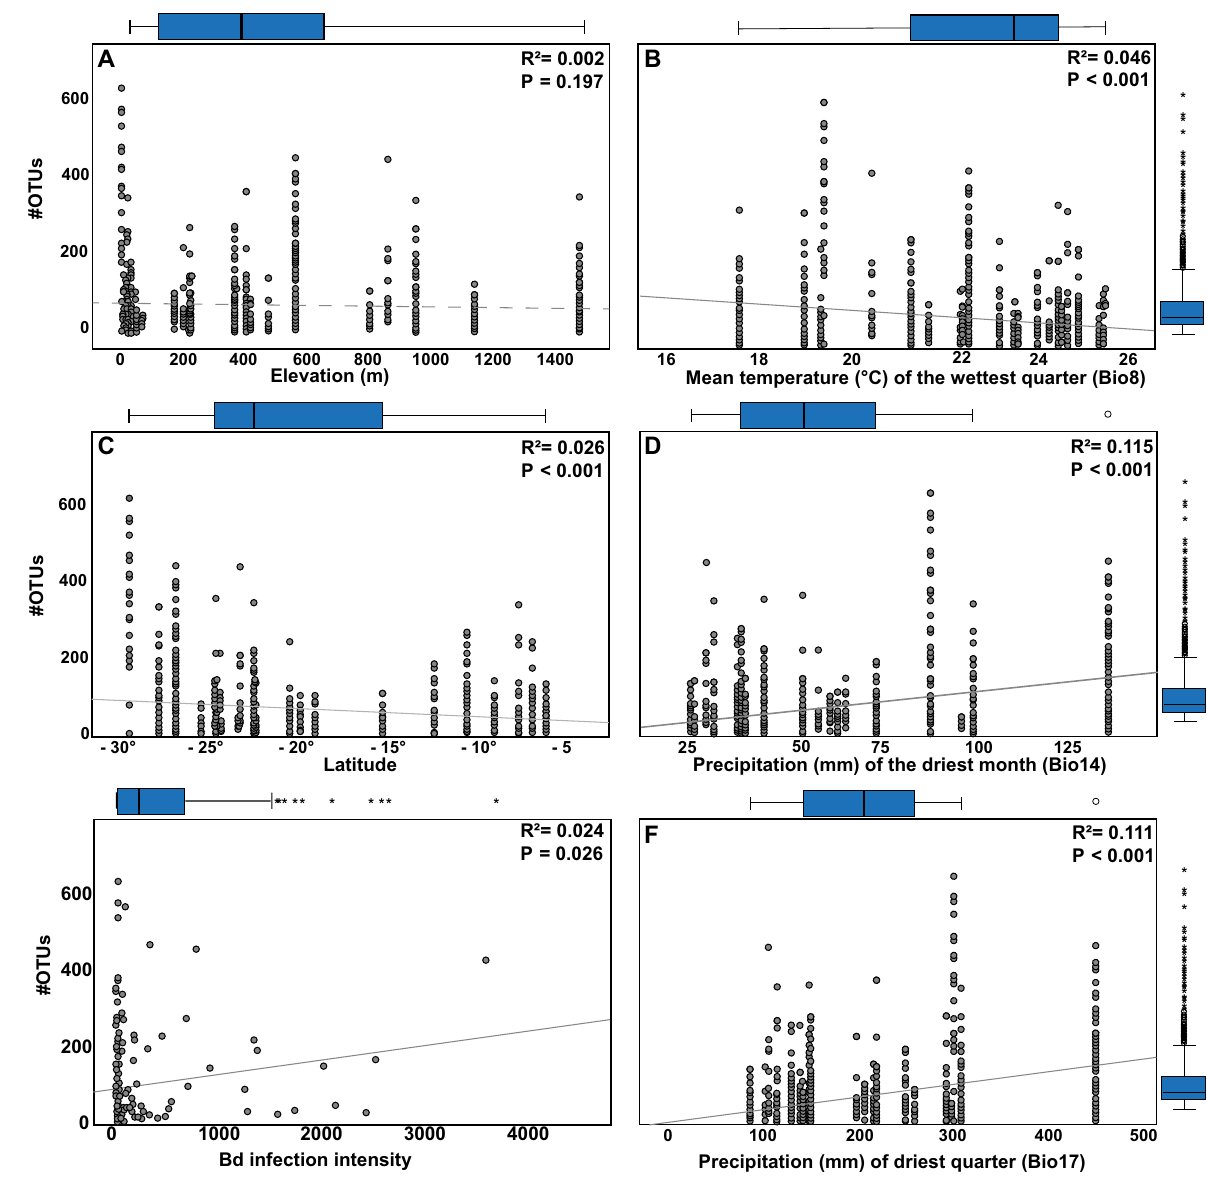
Figure 2. Richness (i.e. #OTUs) of treefrog (N = 819) skin bacterial communities is negatively correlated with ( B ) Mean Temperature (°C) of the Wettest Quarter (Bio8) and ( C ) latitude, but positively associated with ( D ) Precipitation (mm) of the Driest Month (Bio14), and ( F ) Precipitation (mm) of the Driest Quarter (Bio17) as well as ( E ) Batrachochytrium dendrobatidis (Bd) infection intensity (zero values and maximum extreme values were removed from analysis E ). ( A ) Elevation as well as ( E ) Batrachochytrium dendrobatidis (Bd) infection intensity (N = 188; zero values were removed from analysis E ) did not affect alpha diversity in treefrogs in the Atlantic Forest. Solid and dotted regression lines for significant and non-significant correlations, respectively. Error bar = median. Box = 1. and 3. quartiles. Dots = outliers, minimum and maximum values. Whiskers = 1.5- fold interquartile